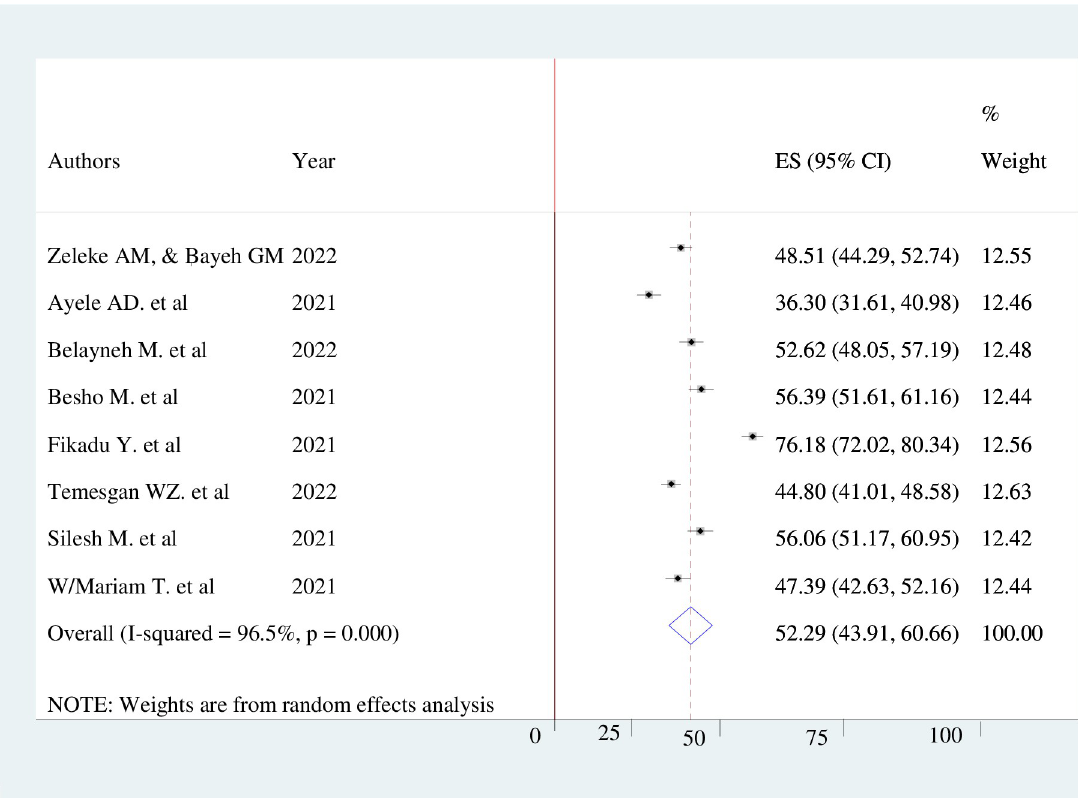
Fig 4. Pooled level of good practice of pregnant women’s towards COVID-19 infection